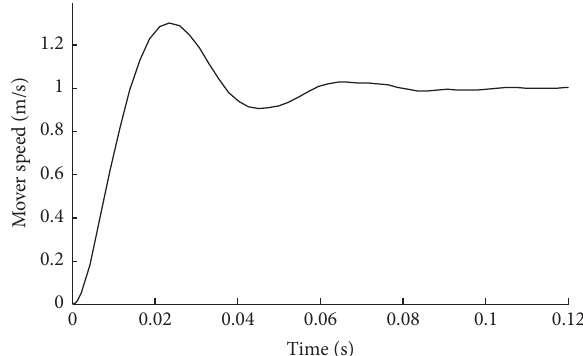
Figure 12: Simulation results of the mover velocity under no-load for ] = 1 m/s.